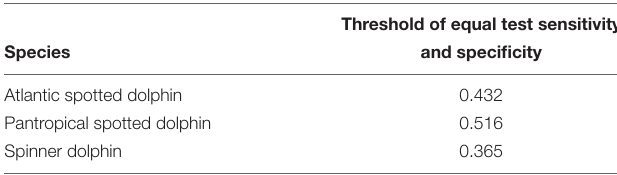
TABLE 4 | Threshold of equal test sensitivity and specificity obtained for each model generated among three Stenella species in the Caribbean Basin.